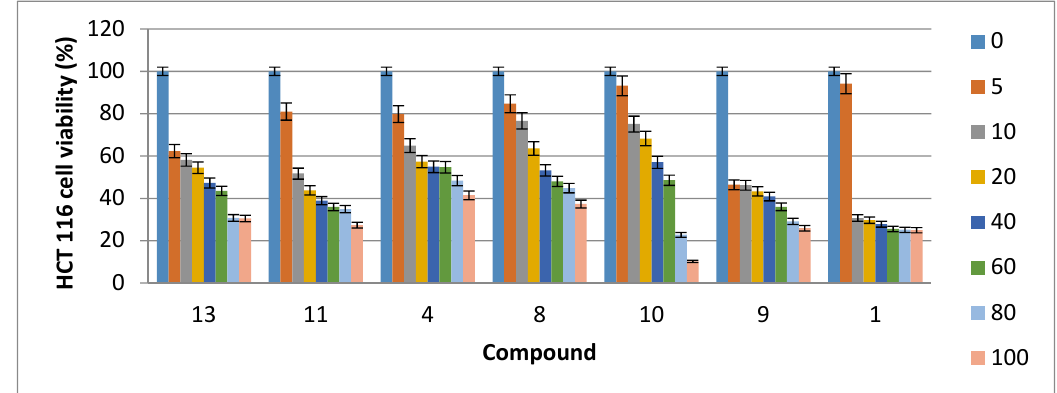
Figure 2. Anti-proliferative activities of compounds against human colorectal cancer HCT 116 cells. The MTT assay was performed three independent times ( n = 3) using different concentrations of the mentioned compounds.